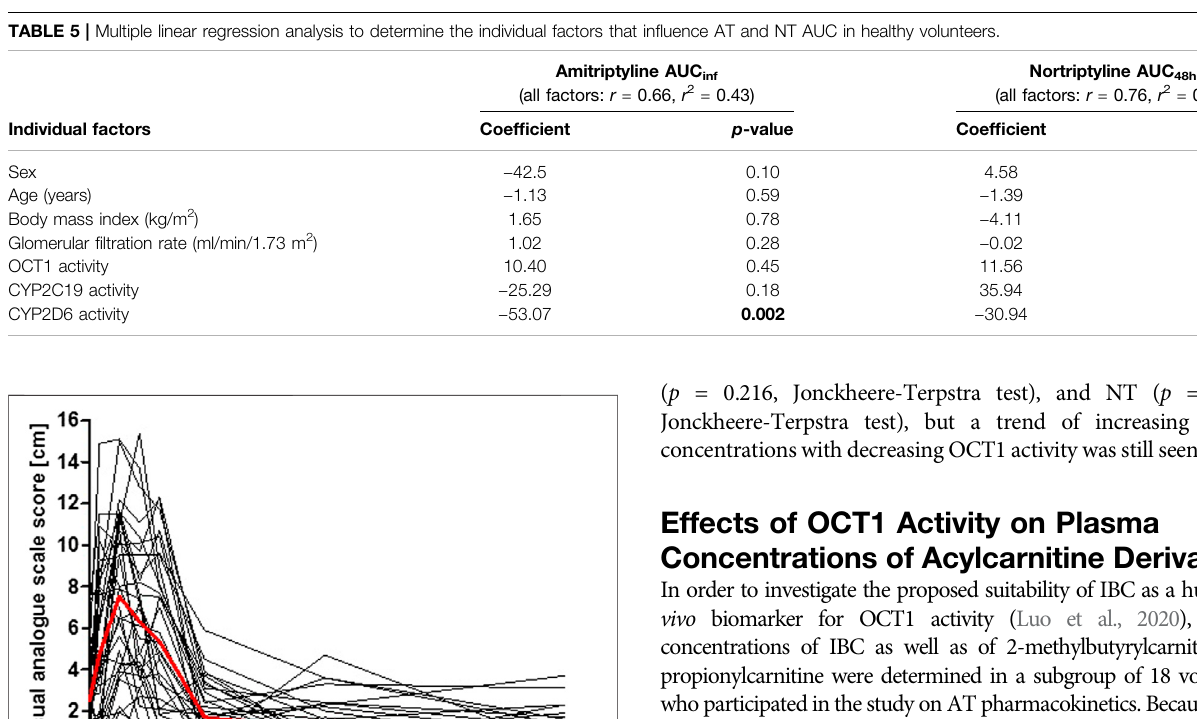
Data are shown as the mean. The study population was not selected based on their CYP2C19 genotypes. a For calculating the CYP2C19 activity score, CYP2C19*2 was regarded as zero active, CYP2C19*1 was classi fi ed as 1, and CYP2C19*17 as 1.5. b Differences were analysed for statistical signi fi cance using the Jonckheere-Terpstra test. Signi fi cant values are highlighted in bold. c Intwosubjects with CYP2C19*1/*17genotypeand inone subjectwith CYP2C19*1/*1genotype,nodecreasein NTconcentrationwas observedand, therefore, noterminalelimination rate could be calculated.